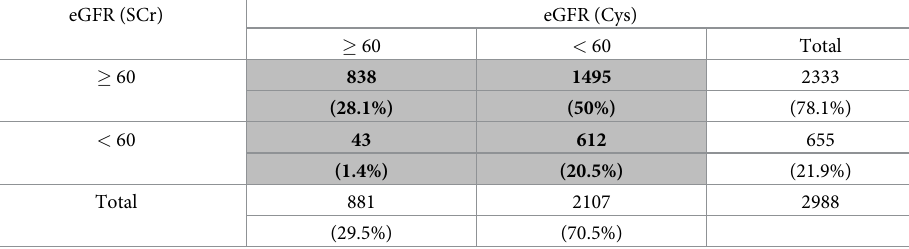
Table 2. Comparison of CKD diagnosis by